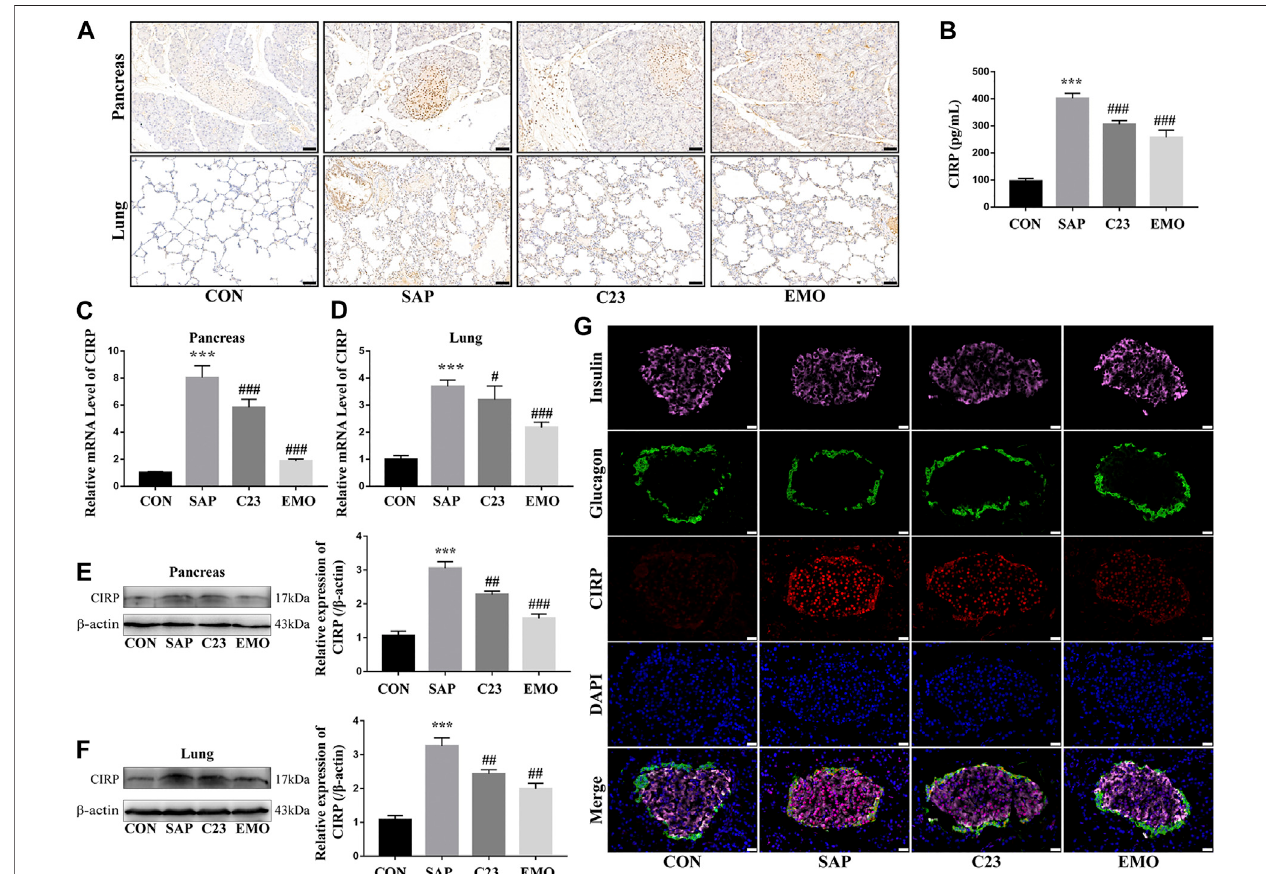
FIGURE2| Treatmentwithemodinsigni fi cantlyattenuatestheSAP-inducedCIRPexpressioninrats. (A) ImmunohistochemistryanalysisofCIRPexpressioninthe pancreaticandlungtissues(200 × magni fi cation).Scalebar (cid:1) 50 μ m. (B) ELISAanalysisofserumCIRPlevels. (C,D) QuantitativeRT-PCRanalysisoftherelativelevelsof CIRP to the control GAPDH mRNA transcripts in the pancreatic and lung tissues of rats. (E, F) Western blot analysis of the relative levels of CIRP to the control β -actin expression in the pancreatic and lung tissues of rats. (G) Immuno fl uorescent analysis of CIRP expression in the pancreatic islets using anti-CIRP (red), anti-insulin (pink), and anti-glucagon (green, 400 × magni fi cation). Scale bar (cid:1) 20 μ m. The data are representative images or expressed as mean ± SD of each group of rats ( n (cid:1) 10 per group) from at least three separate experiments; *** p < 0.001 vs. the CON. # p < 0.05, ## p < 0.01, ### p < 0.001 vs. the